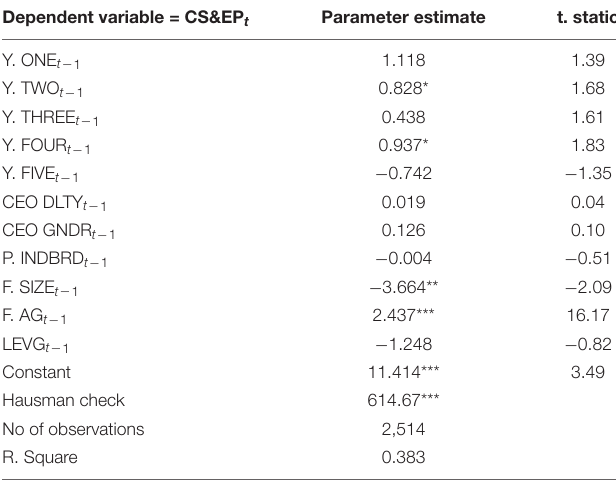
TABLE 7 | CEO tenure and CS&EP: The impact of Coastal areas.